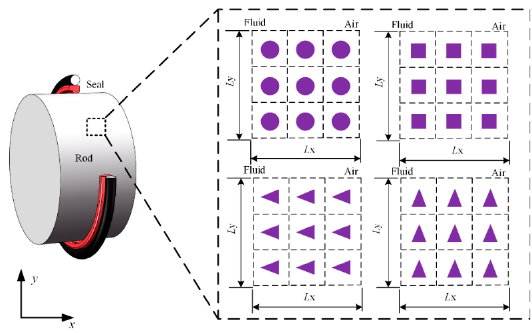
Figure 1. Textured rod surfaces.